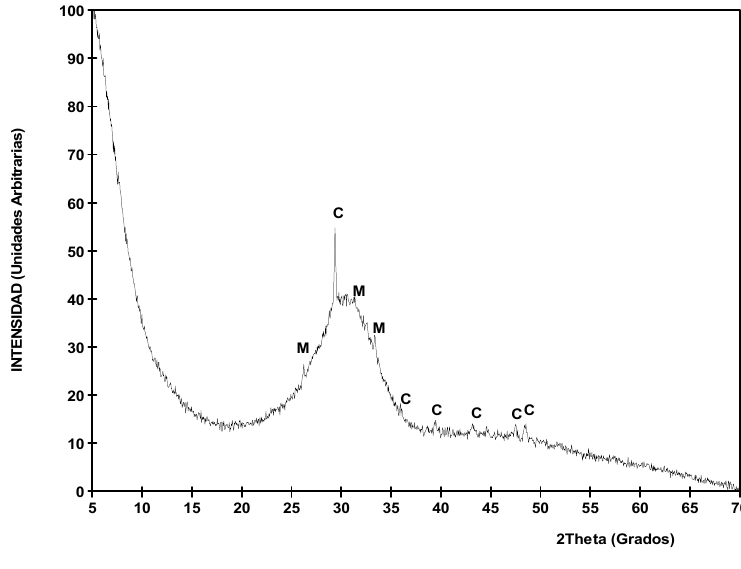
Figure 4. Diffractogram of X rays of the GBFS.